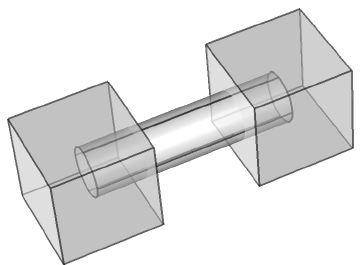
Fig. 4: Example geometric model with interior features shown.